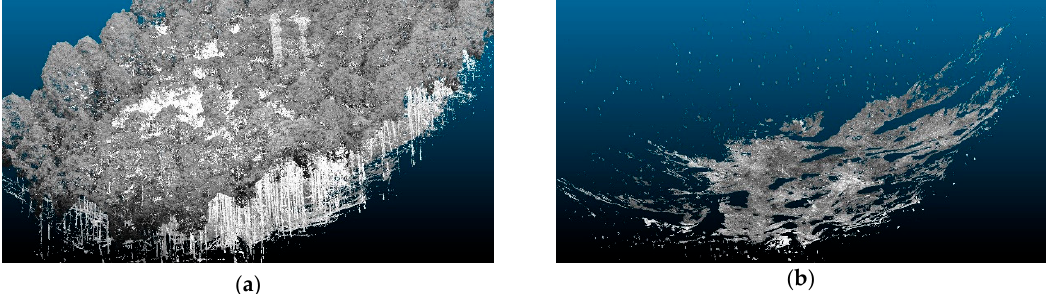
Figure 7. Dense point cloud of the merged UAS SfM points and TLS points of the study site ( a ) before the CSF filter and ( b ) after the filtering. The CSF successfully excluded the top surface objects (e.g., trees, the tower, etc.) and left only the surface terrain.